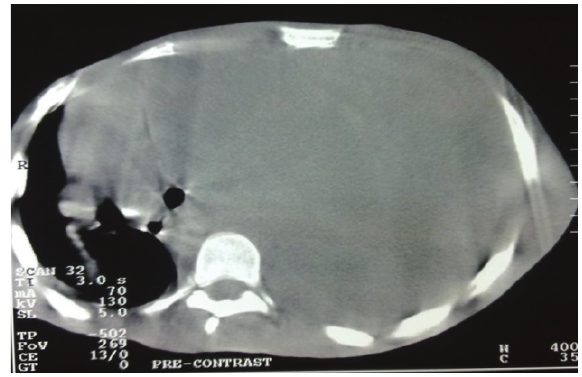
Figure 3: Chest CT scan showing non-enhancing mass, isodense to surrounding muscle completely occupying the entire left hemitho-